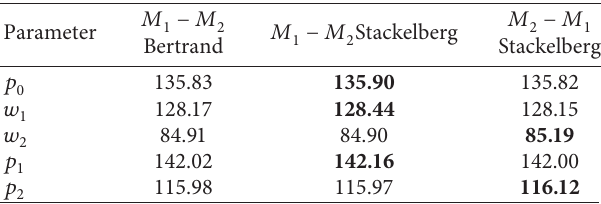
Table 3: Optimal pricing decision under different scenarios.